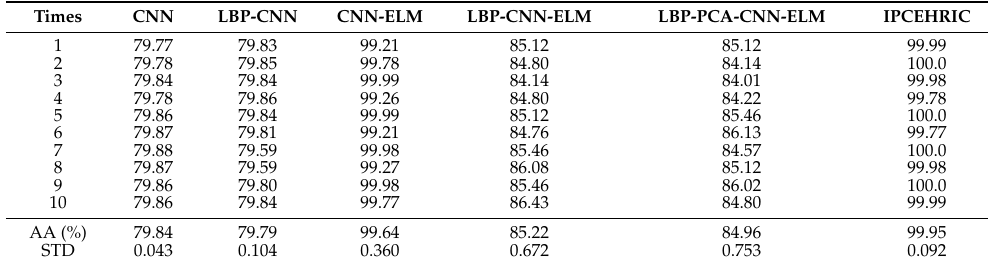
Table 8. The classification results of HRSIs for 10 times for six types (%).